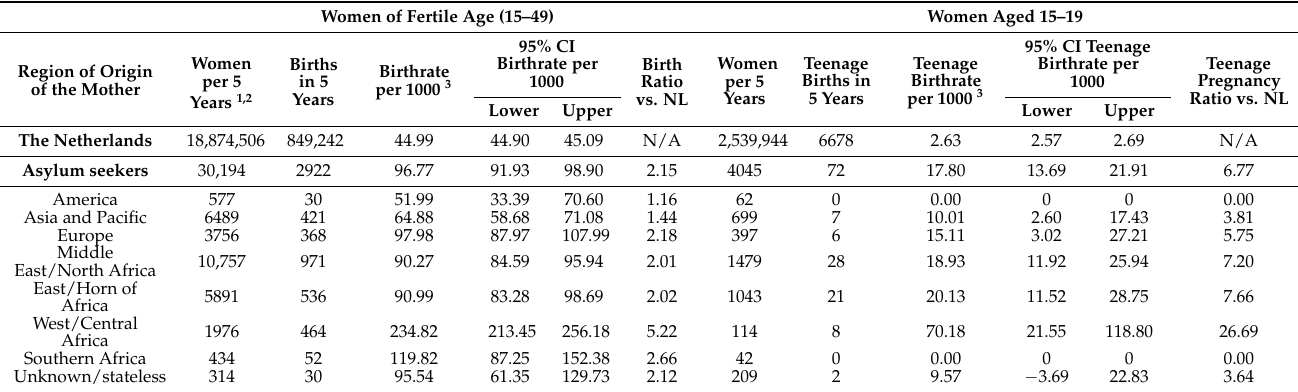
Table 2. Variation in (teenage) birthrates among asylum seekers between different regions of origin compared to the Dutch population.